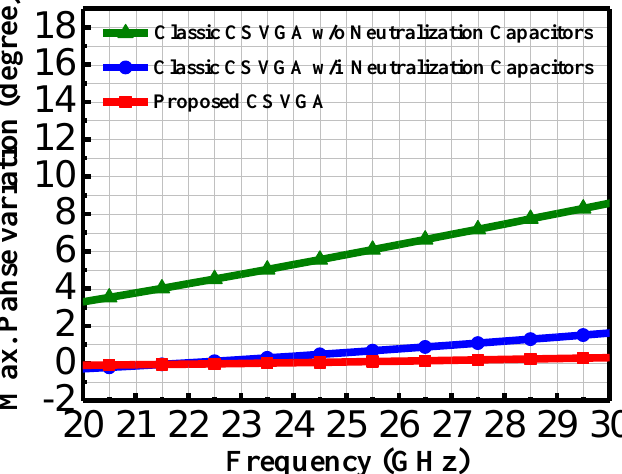
Figure 5. Simulated maximum phase variation in the classic CS VGAs and the proposed active neu- tralization-based CS VGA across 20 – 30 GHz under the same gain adjustment range.